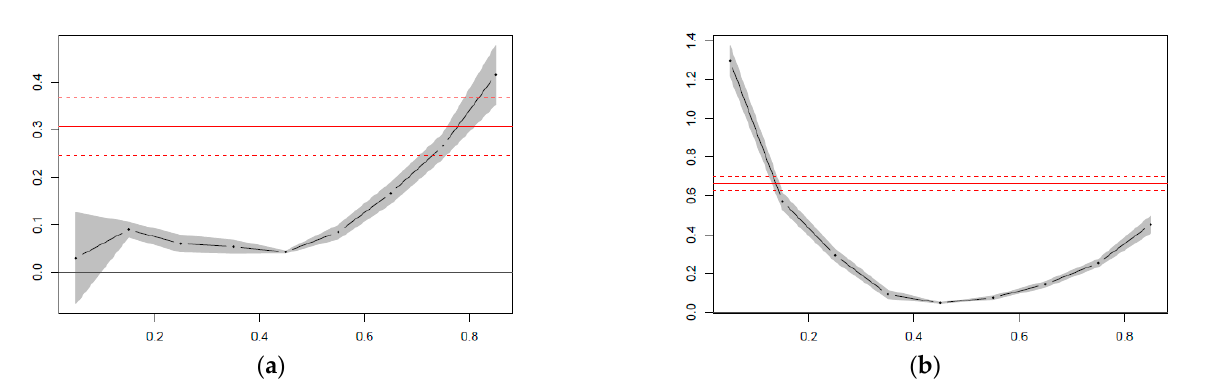
Figure A1. Non-regulated and regulated demand effects on the electricity spot price under the threshold levels: (0.05, 0.85), for February–September of 2020. The variables are defined as follows: ( a ) effects of the non-regulated demand; ( b ) effects of the regulated demand. Table A4. Quantile regression coefficients for the threshold levels (0.05, 0.85) in 2020. 𝜷 𝟎.𝟏 𝜷 𝟎.𝟐 𝜷 𝟎.𝟑 𝜷 𝟎.𝟒 𝜷 𝟎.𝟓 𝜷 𝟎.𝟔 𝜷 𝟎.𝟕 𝜷 𝟎.𝟖 𝜷 𝟎.𝟗